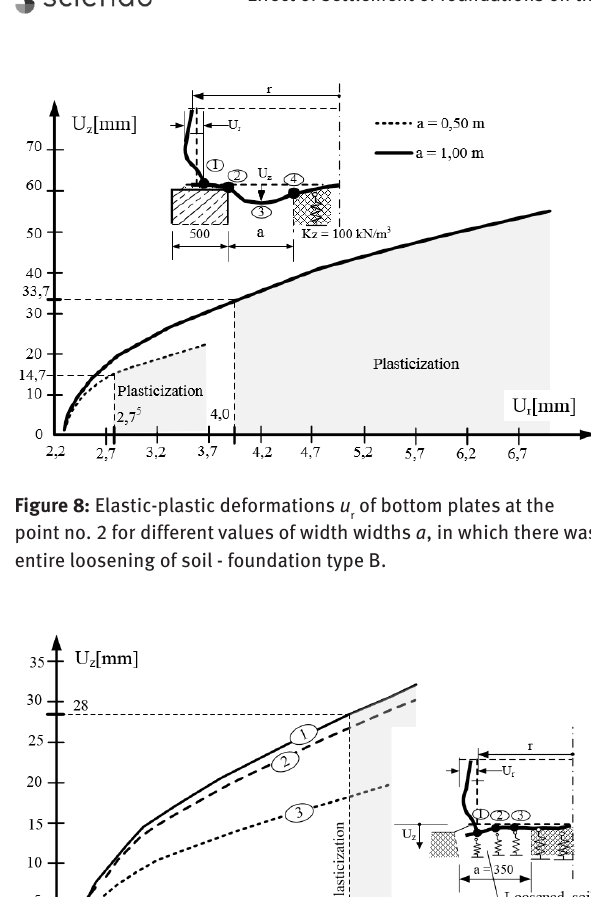
Figure 9: Elastic-plastic deformation of the bottom plate u no. 1 with significant loosening of the soil at the width a = 350 mm - foundation type C.